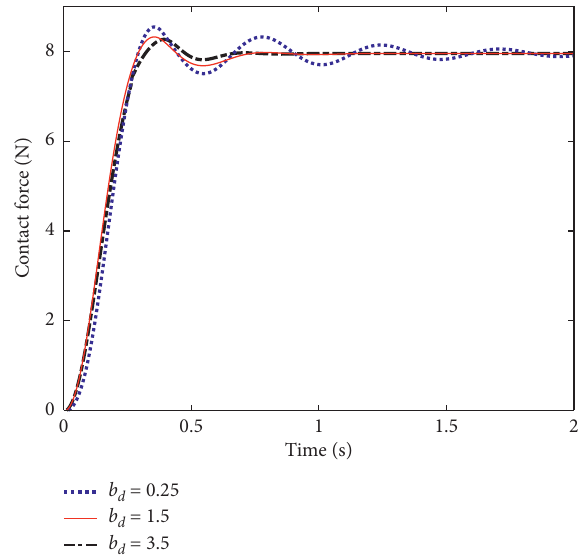
Figure 12: Contact force curves with different damping parameters.